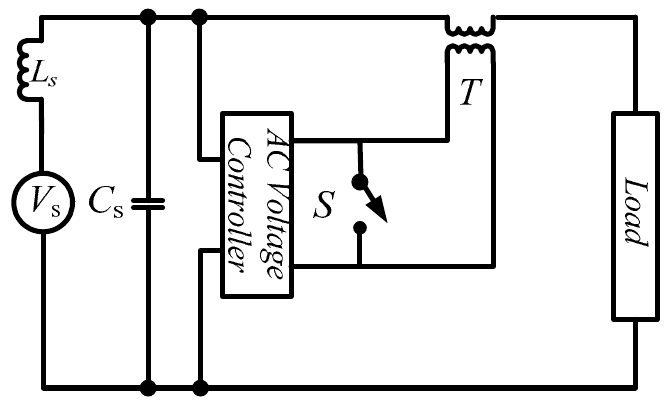
Figure 9. Test circuit for the voltage compensation process.